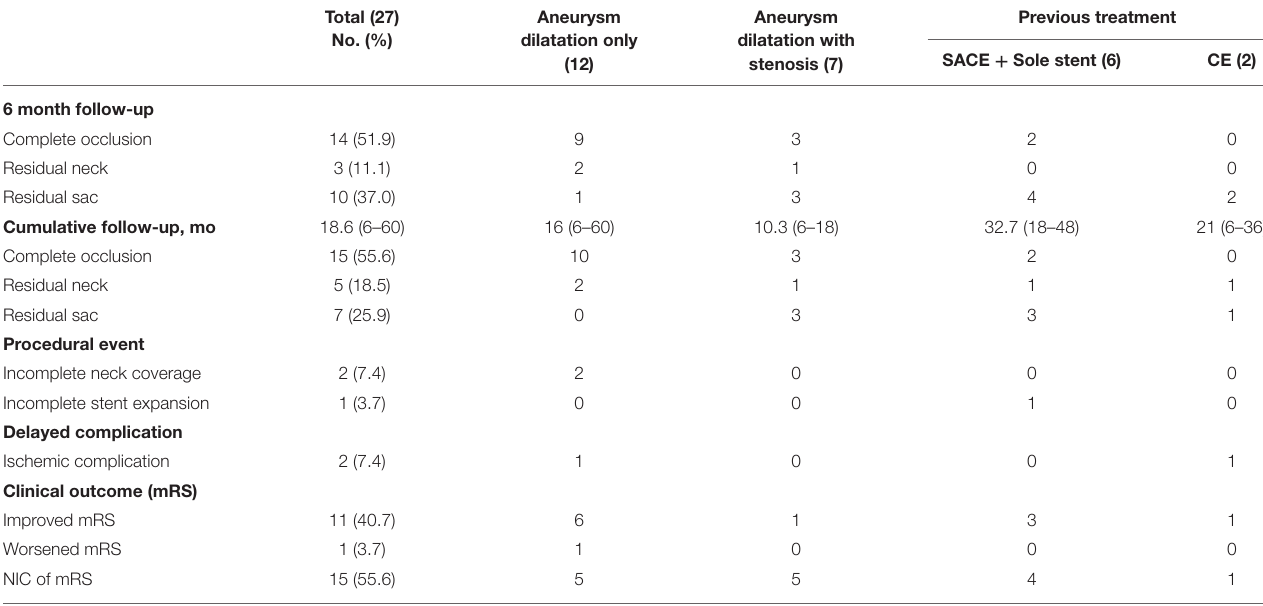
TABLE 2 | Radiologic and clinical follow-up outcome after